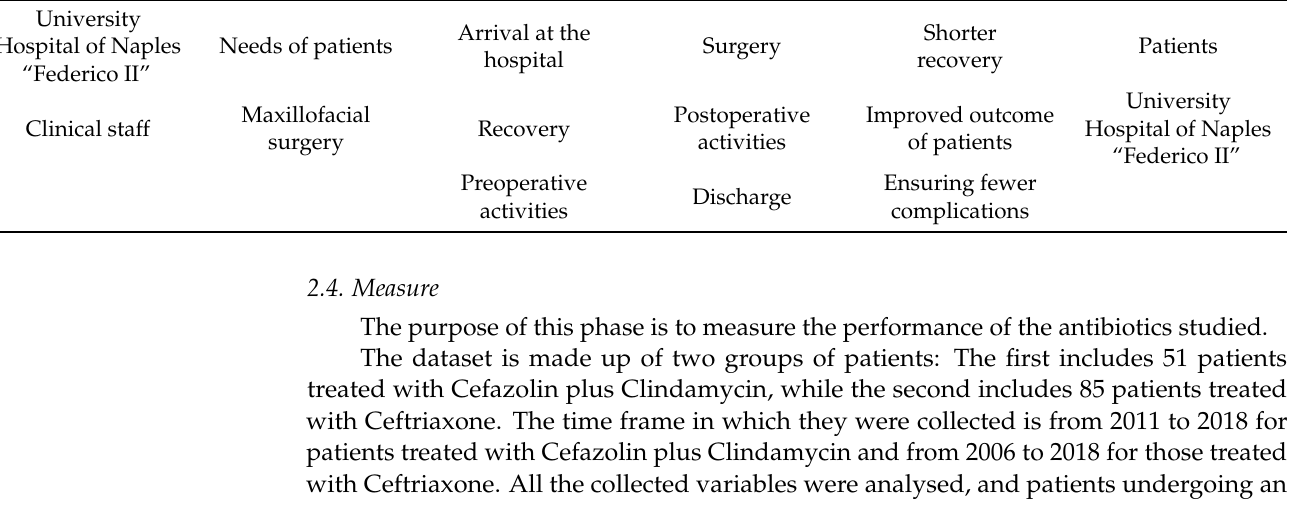
Table 1. SIPOC diagram.